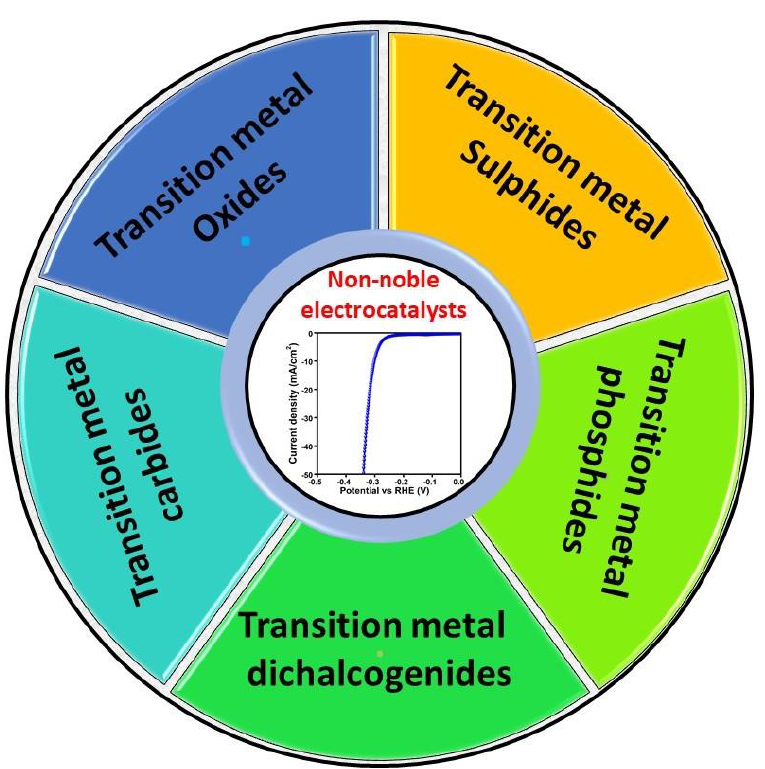
Figure 4. Illustration for various non-noble metal-based electrocatalysts toward HER.